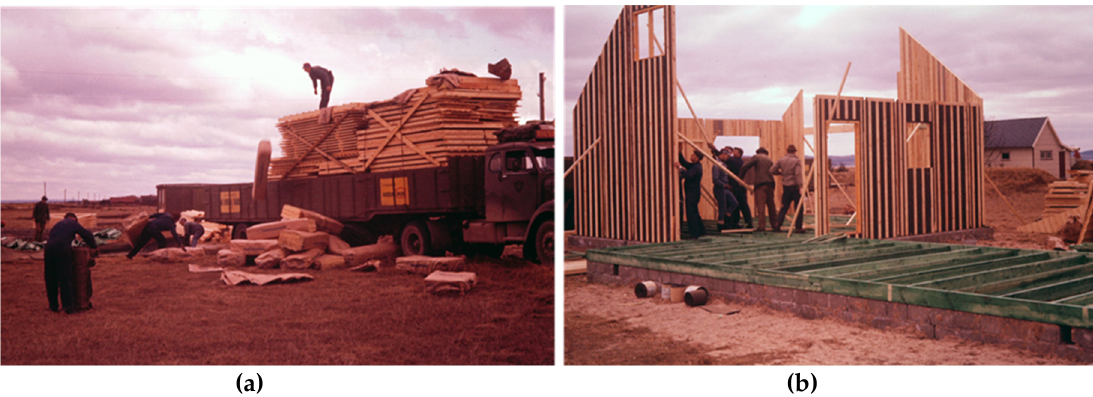
Figure 3. ( a ) Delivery in the early 1960s of a house from ÅsedaHus, one of many companies that produced prefabricated homes in the 1960s and 1970s [32], as well as, e.g., kindergartens, schools and offices. ( b ) The house is erected on a ventilated crawlspace with preserved wood (green) that will eventually be invisible below the interior flooring. ÅsedaHus used KP-Cuprinol for impregnation and chlorophenols (CPs) for dipping, as reported by the company [33] and supported by historical investigation before sampling of soil [34] and analyses of polluted soils showing CPs and dioxins at the manufacturing site